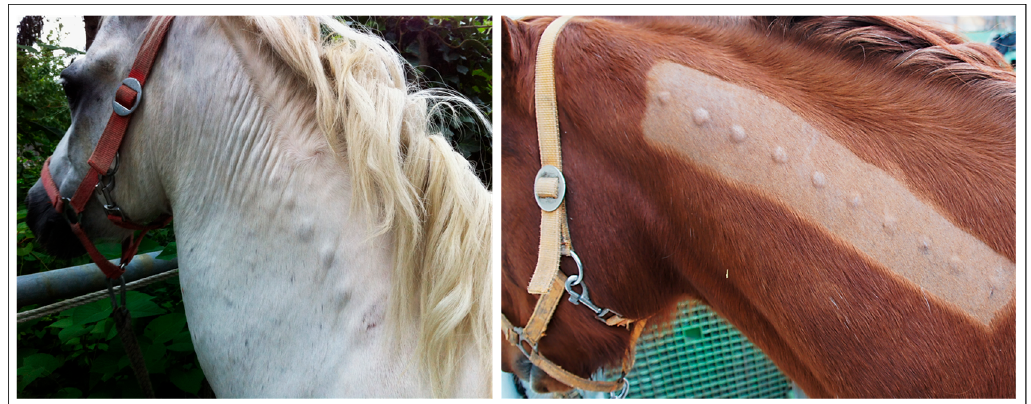
Figure 4. Experimental by bovine δ -PV type 1 (BPV1)-induced pseudo-sarcoids. Intradermal inocu- lation of horses with confirmedly infectious BPV1/2 virions isolated from cow warts consistently resulted in the development of nodular pseudo-sarcoids, as shown in the examples of a pony (left) and a Warmblood gelding (right) inoculated at ten sites of the neck. Lesions morphologically and histologically resembled naturally acquired sarcoids but regressed spontaneously.